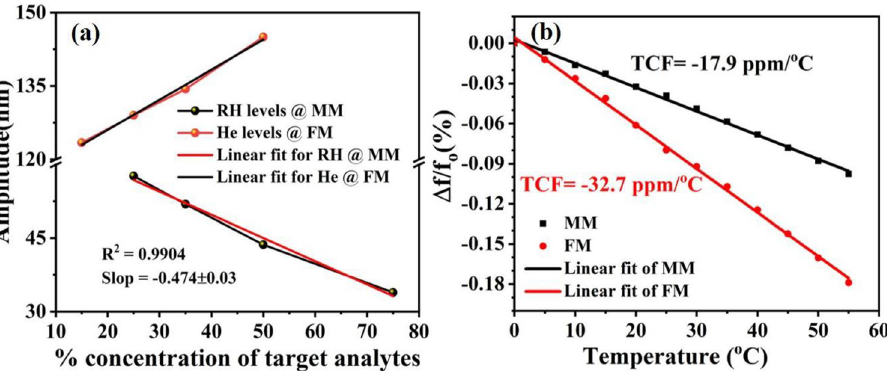
Figure 14. ( a ) The experimental and calculated linear fit results for different levels of RH at MM and He at FM (simultaneous actuation), and ( b ) simulated temperature dependence of frequency (TCF) of the device for both modes.